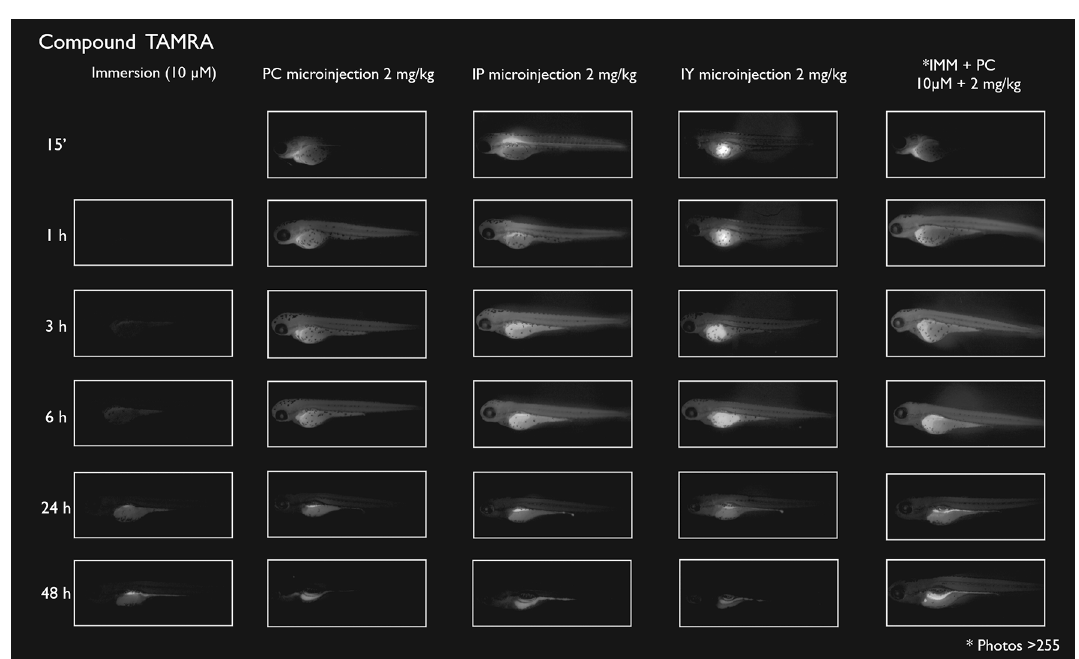
Figure 5. Representative pictures of the spatiotemporal distribution of the fluorescent compound TAMRA. The eleuthero-embryos were exposed to the dye by immersion (10 µM) or microinjection (2 mg/kg) in the pericardial cavity (PC), intraperitoneally (IP) and in the yolk sac (IY), or by a combination of immersion and PC microinjection, for 48 h starting from 3 dpf. Selected images arranged in MS PowerPoint and GIMP (version 2.10.24 https:// www. gimp. org/ 2021)